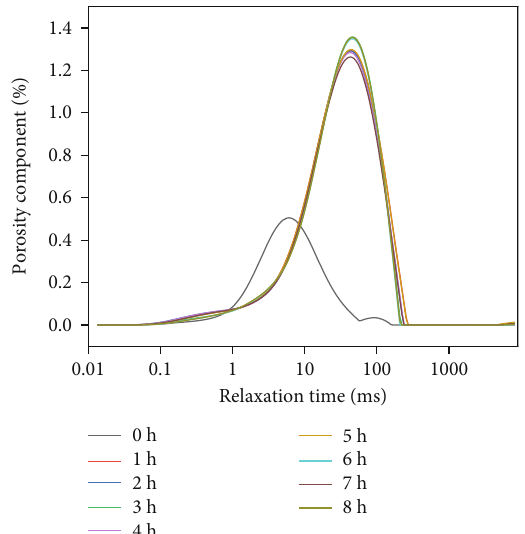
ff erent leaching times.